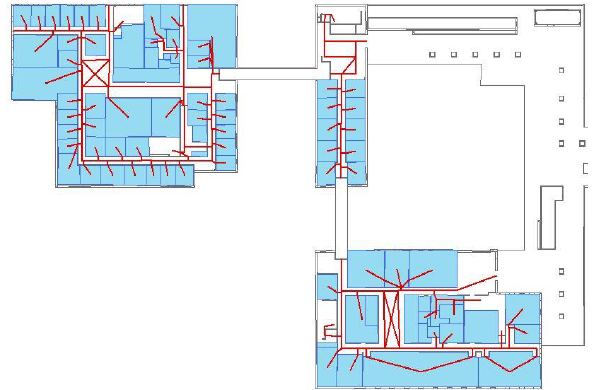
Figure 4. The imported BIM model in ArcScene Figure 5. The generated topological network map in GIS